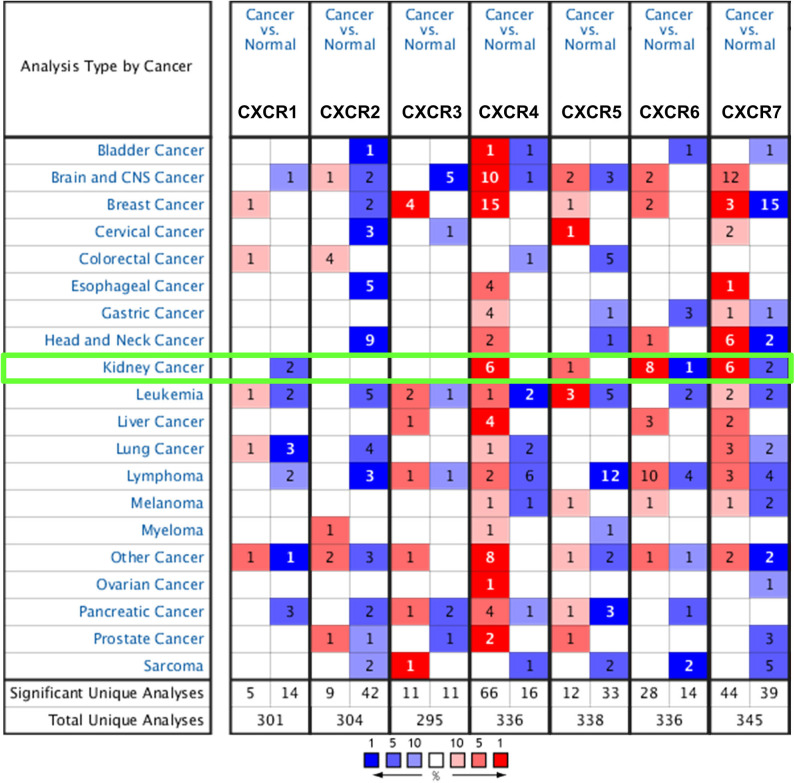
The mRNA expression of CXCRs (cancer vs. normal tissue of kidney) was assessed using the ONCOMINE database. Red represents significant overexpression and blue represents reduced expression. The number in each cell stands for the number of analyses that meet the threshold.